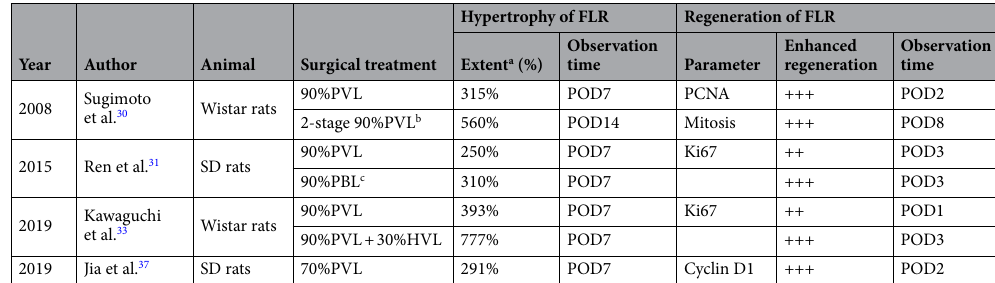
Table 1. Experimental studies investigating regeneration in non-ligated liver (FLR) after PVL in rat model. SD rats Sprague–Dawley rats, HVL hepatic vein ligation, + mild increase, ++ moderate increase, +++ substantial increase. a Weight ratio of the non-ligated liver lobe to pre-operative value. b 2-stage PVL: first stage: 70%PVL, second stage: 20%PVL on POD7. c PBL: simultaneous portal vein ligation and bile duct